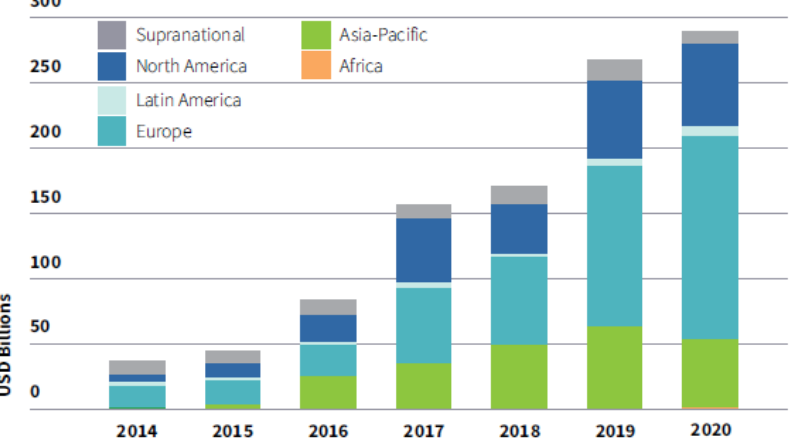
Figure 1. Green bond issuance by region (2014–2020). Source: Harrison and Muething (2021); p. 6.